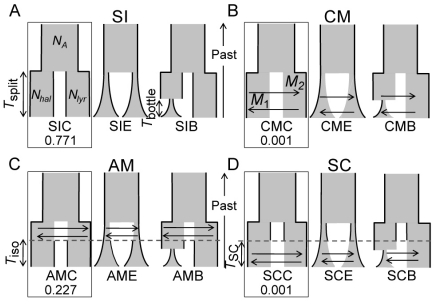
Alternative scenarios of speciation for A. halleri and A. lyrata.Four classes of scenarios according to the pattern of migration: strict isolation (SI), constant migration (CM), ancient migration (AM) and secondary contact (SC). Three alternative models within each class of scenarios: constant population size (SIC, CMC, AMC, SCC), exponential population growth (SIE, CME, AME, SCE) and bottleneck specific to A. halleri followed by exponential population growth (SIB, CMB, AMB, SCB). The migration rate M is expressed in 4 Nm units, where m is the proportion of a population made up of migrants from the other population per generation. N is the effective population size expressed in numbers of individuals. A. halleri (Nhal), A. lyrata (Nlyr), or the ancestor (NA). The posterior probabilities of the best model selected under each scenario are reported.